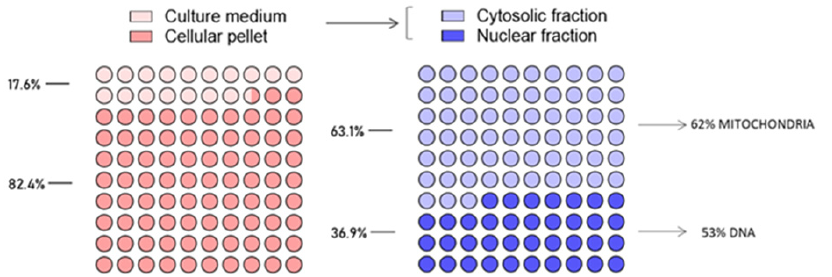
Figure 3. Intracellular ruthenium(III) complex bioaccumulation after HoThyRu/DOTAP application to MDA-MB-231 cells. Inductively coupled plasma-mass spectrometry (ICP-MS) for the analysis of ruthenium distribution between MDA-MB-231 cells and culture media after incubation for 24 h with the IC 50 concentration of HoThyRu/DOTAP, as well as intracellular ruthenium accumulation following cellular uptake and subcellular fractionation. In the reported fractions, ruthenium content is expressed as percentage of the total ruthenium administered during incubations in vitro. Results were derived from the average values of three independent experiments.